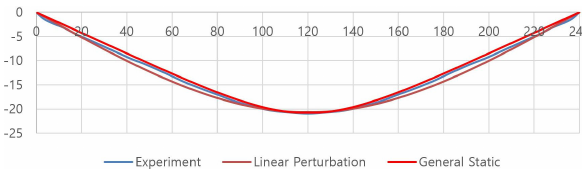
Figure 20: Comparison of bending deformation values on laminate